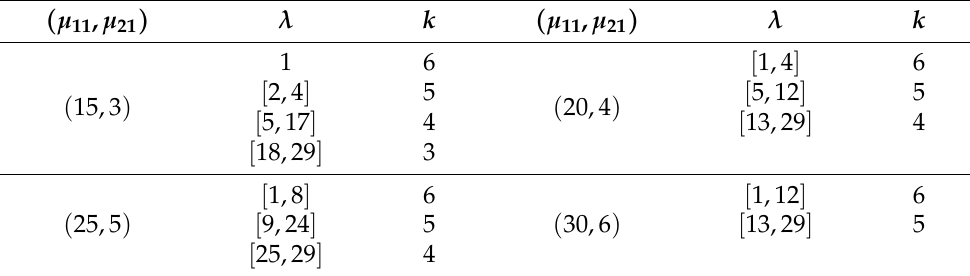
Table 4. Optimal policy k versus λ , µ 11 and µ 21 for fixed µ 12 = 12, µ 22 = 2.4